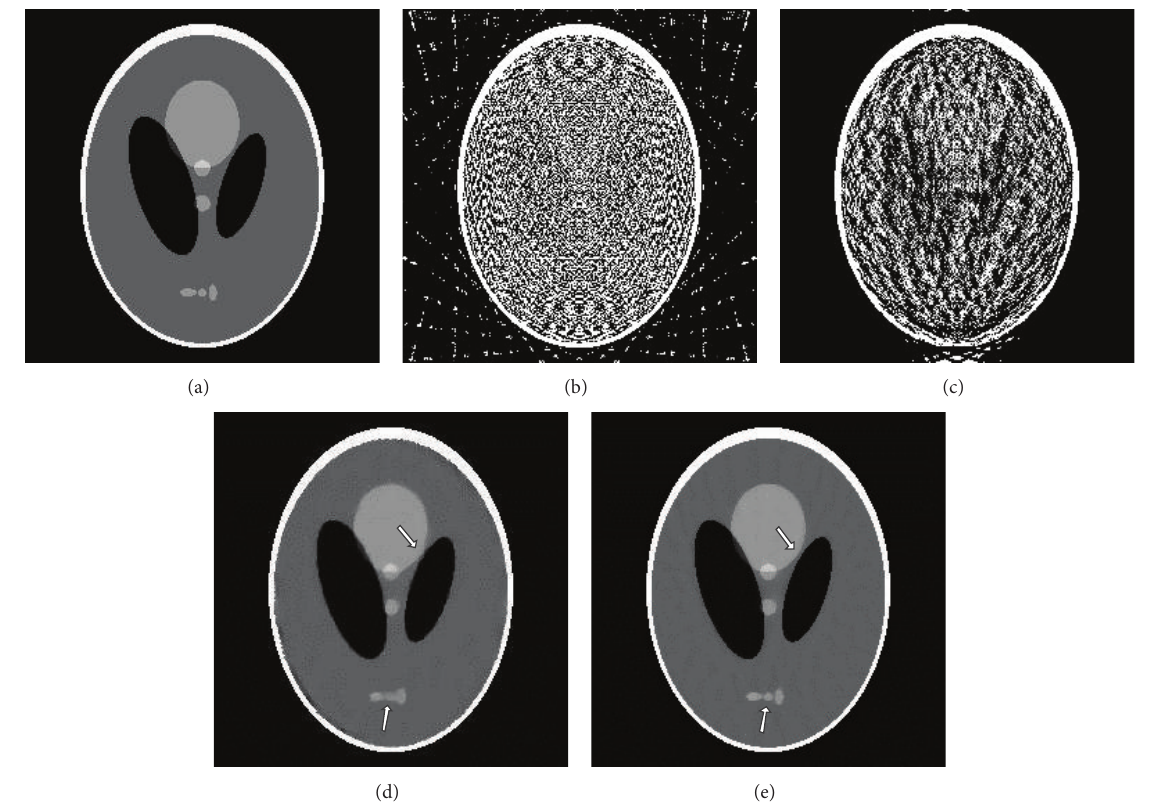
Figure 2: Reconstruction results of Shepp-Logan phantom by different methods. (a) Original, (b) FBP, (c) EM, (d) ASD-POCS, and (e) NLTV.